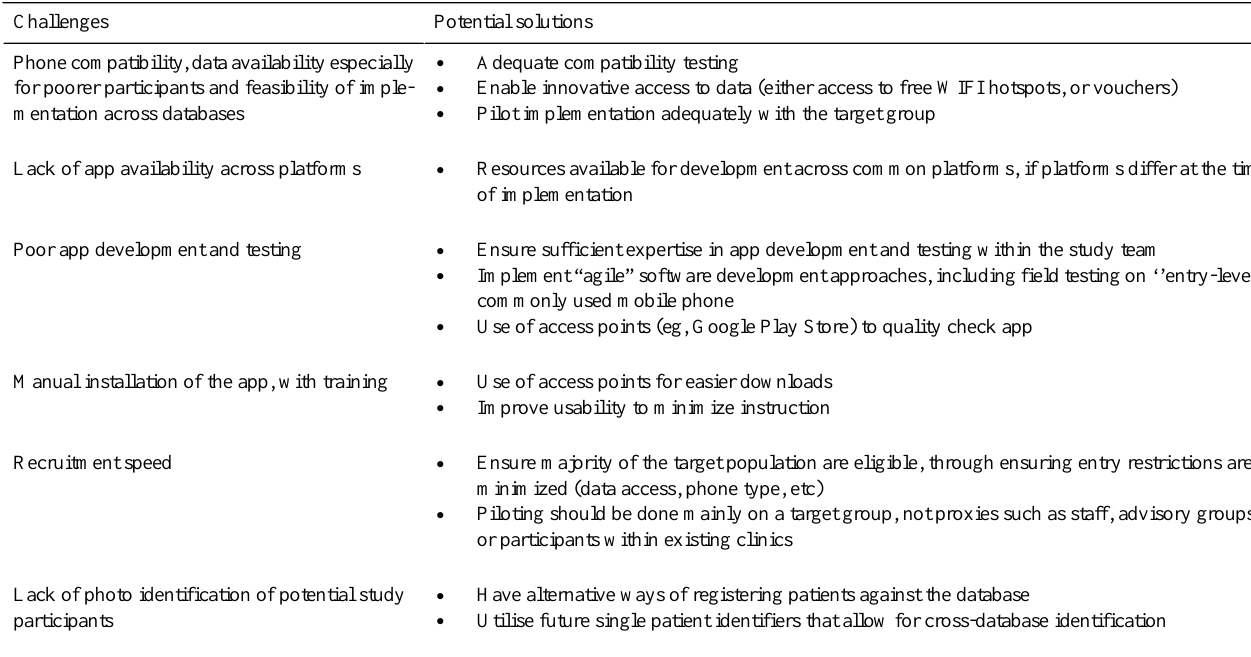
Table 3. Study challenges and solutions.